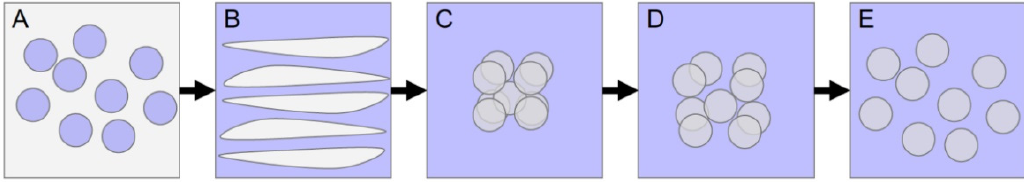
Figure 10. ( A ) Water is titrated into the oil/surfactant solution forming an initial w/o emulsion. ( B ) As water is continued to be added, the w/o emulsion transitions to a bicontinuous phase. ( C ) The bicontinuous phase ends as the surfactant encapsulates oil into droplets, which form a liquid crystal intermediate, resulting in gelation. ( D , E ) Liquid crystal breaks up as it is diluted, with additional water forming a stable o/w emulsion.